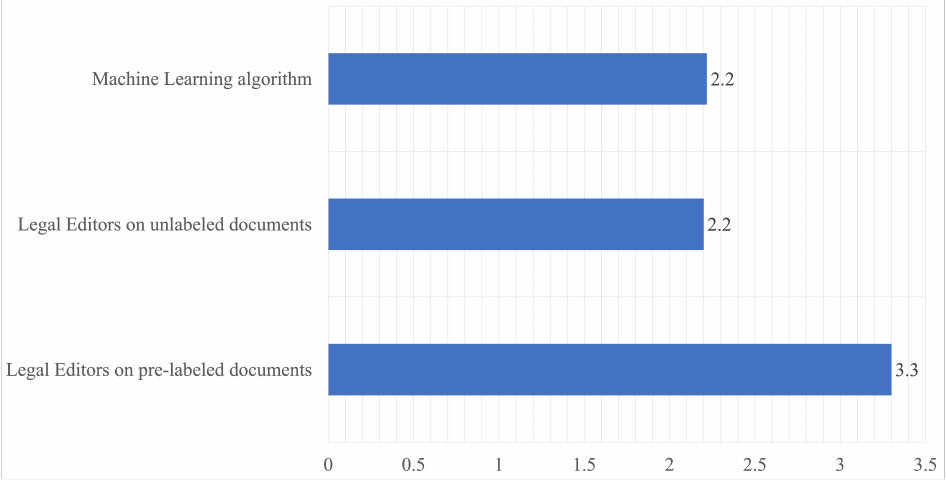
Figure 6. How many points the editors gained from one document in average based on the extracted information content compared to the machine learning algorithm.